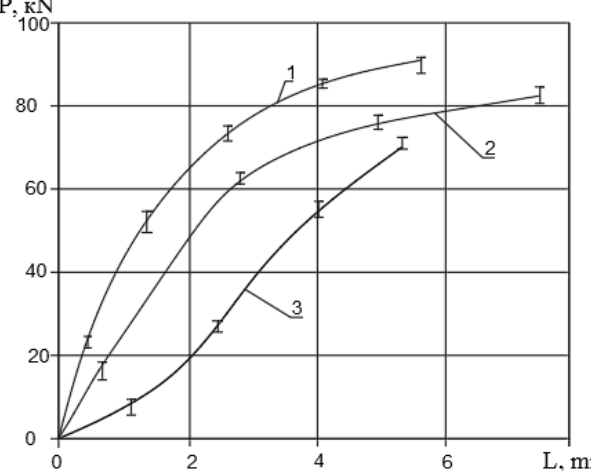
Figure 9. Dependences of deformation forces P at the obtained confidence intervals on the movement L of the work roll during part rolling.